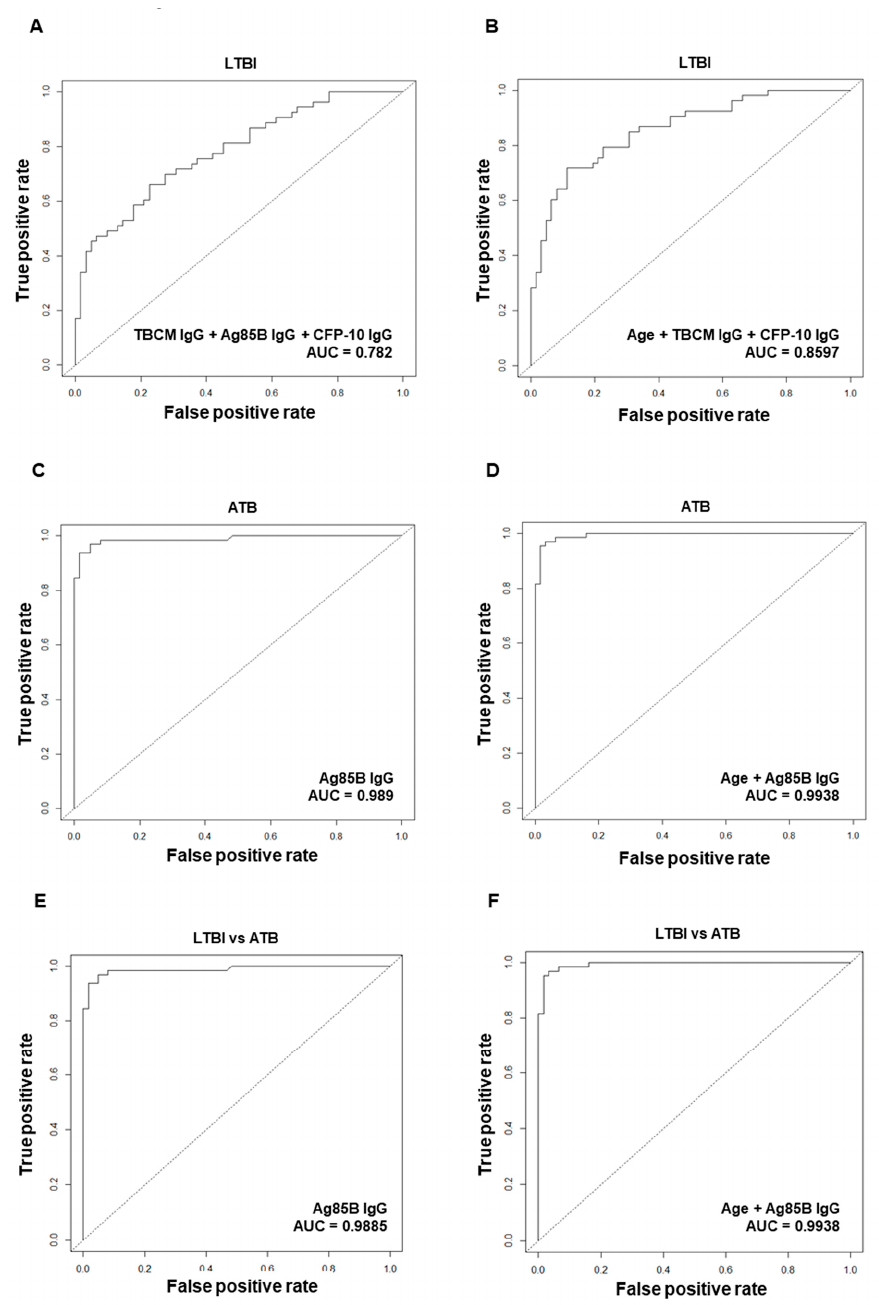
Figure 6. Receiver operating characteristic (ROC) curve analysis and logistic regression models were